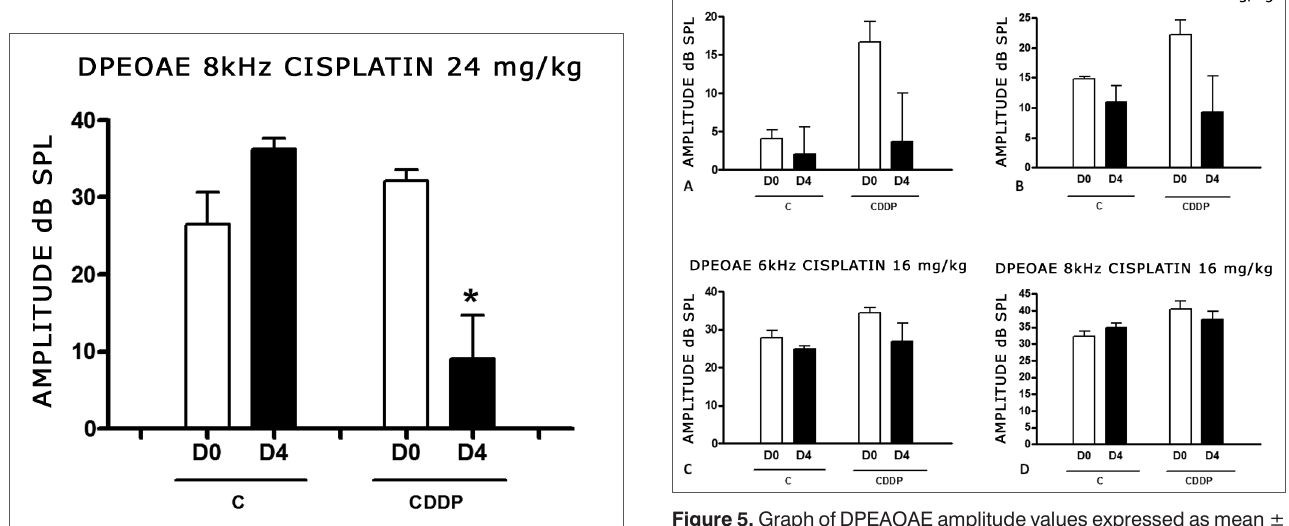
Figure 5. Graph of DPEAOAE amplitude values expressed as mean ± mean standard error in the averages of days D0 and D4, of groups 7 and 8. CDDP = cisplatin; C = control. There was no statistical significance in any of the groups (T test: p >